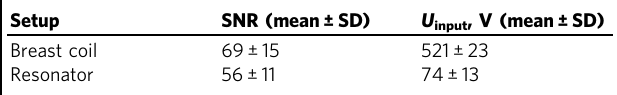
Table 1 The comparison of the signal-to-noise ratio (SNR) and the peak voltage ( U input ) a